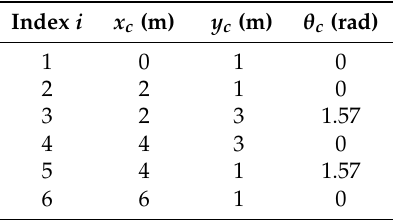
Table 2. The node parameters of the tracking